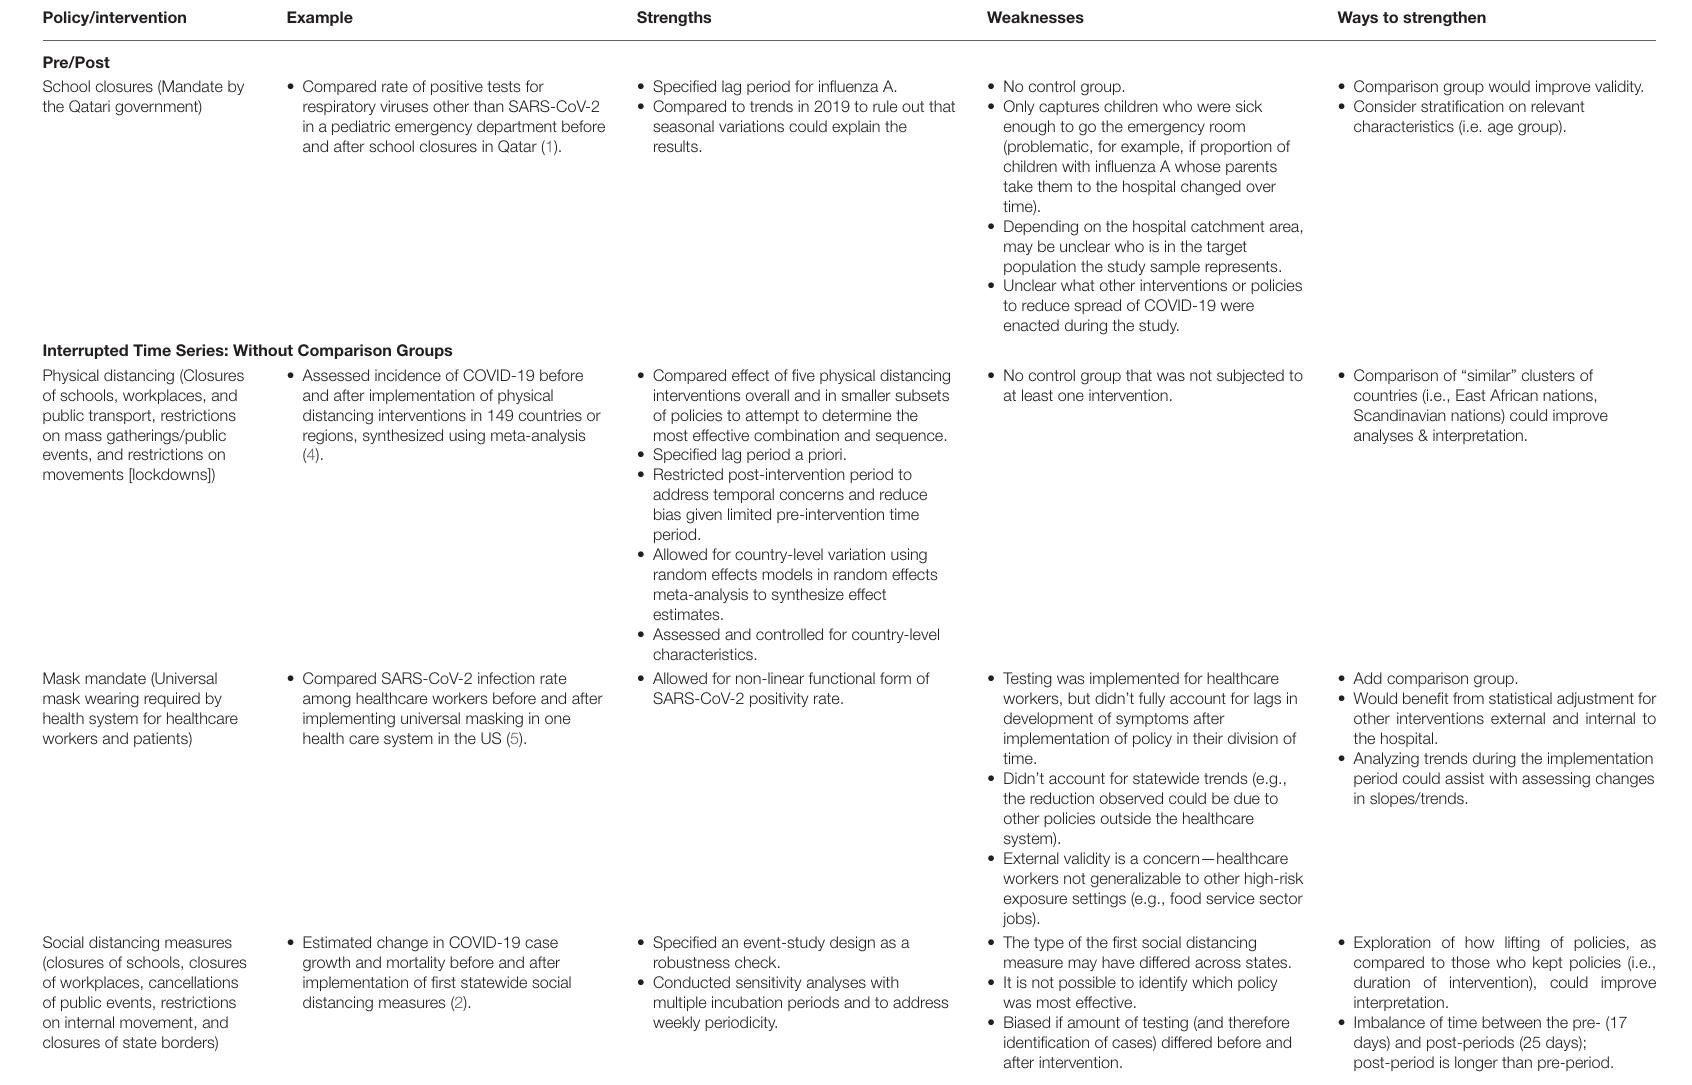
TABLE 2 | Selected examples of quasi-experimental studies evaluating real-world interventions to prevent